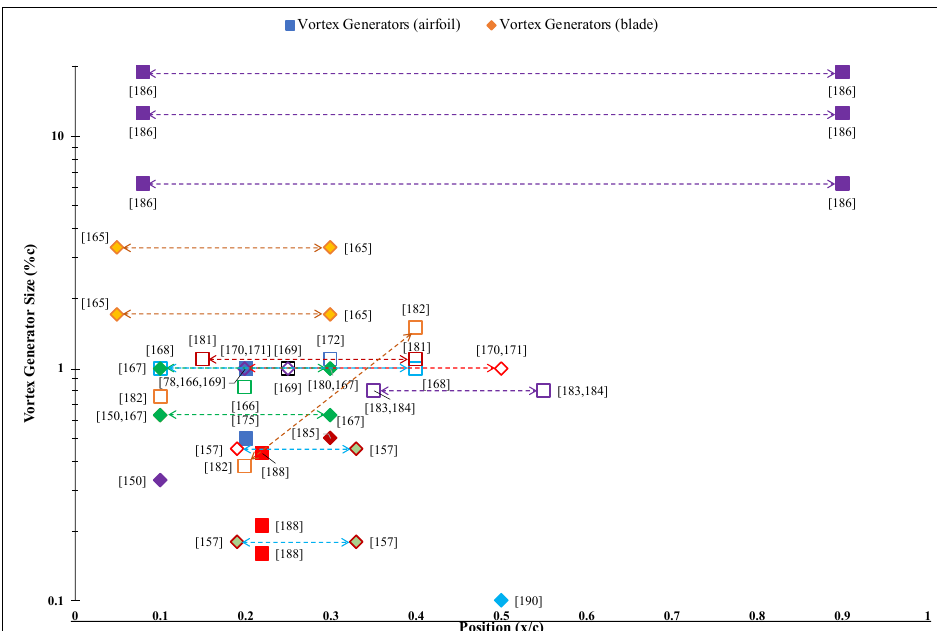
Figure 8. Literature survey of vortex generators. (Empty and filled markers denote numerical and experimental investigations, respectively. Arrows denote the range of